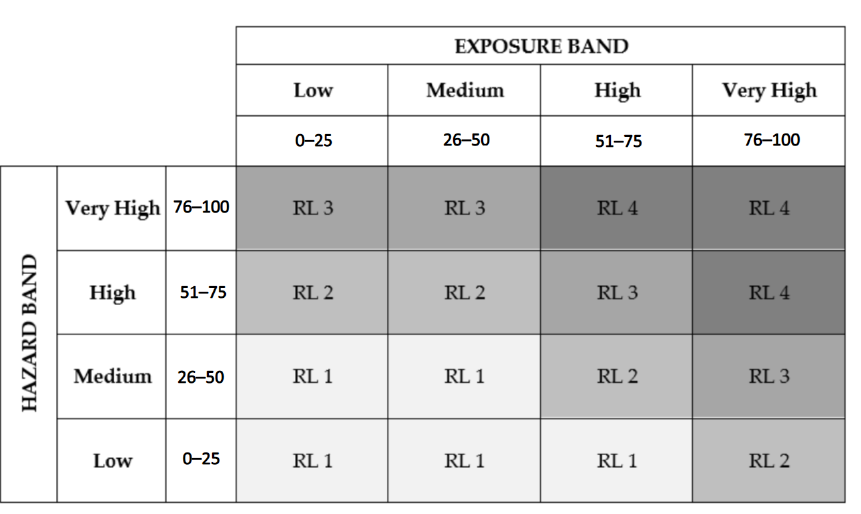
Figure 11. IN Nanotool risk matrix. The darker the color the higher the risk